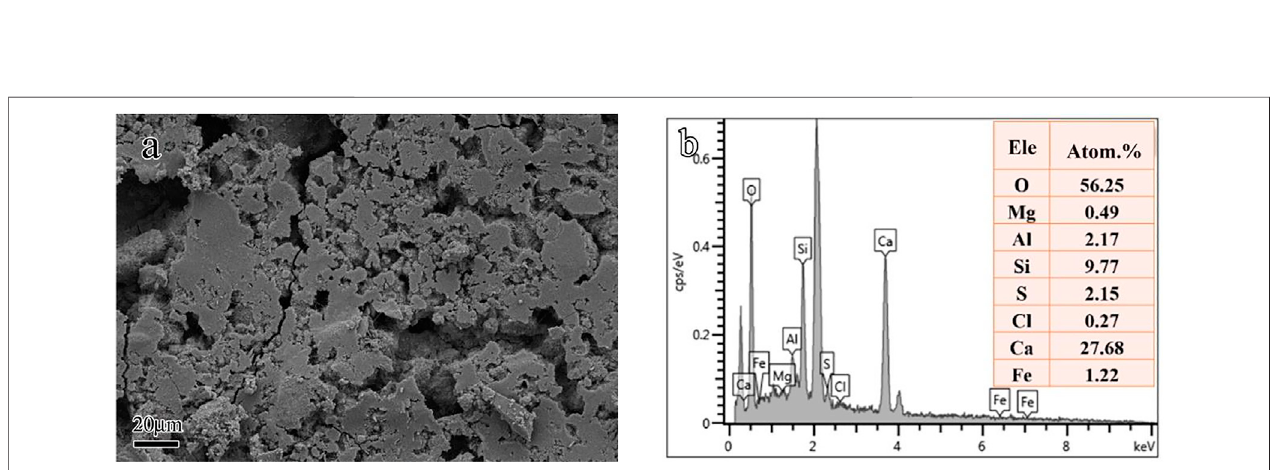
FIGURE 9 | SEM morphology and EDS results of the cement paste in concrete without nano modi fi cation after F/T and W/D cycles in 3 wt% of CaCl 2 solution.